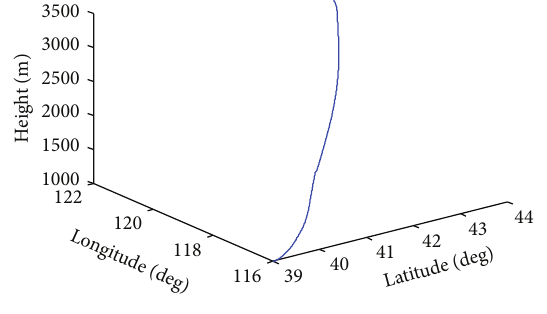
Figure 1: Flight path for